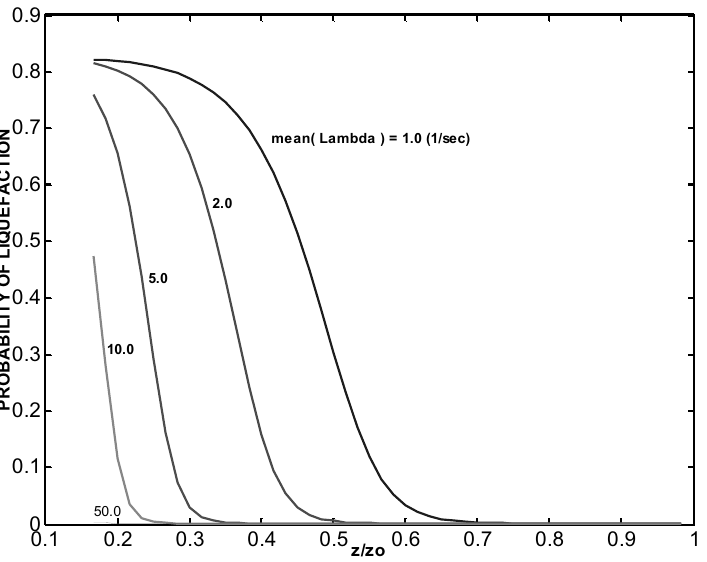
Fig. 5. Variation of the probability of liquefaction with the normalized depth (for several values of the mean time-decay constant of the applied